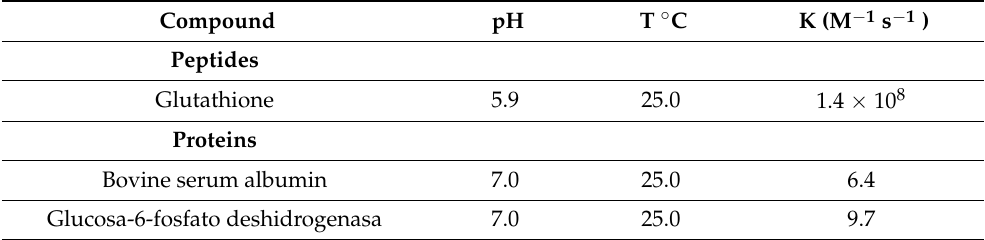
Table 3. Constants determined for ClO 2 reactions with peptides and proteins.